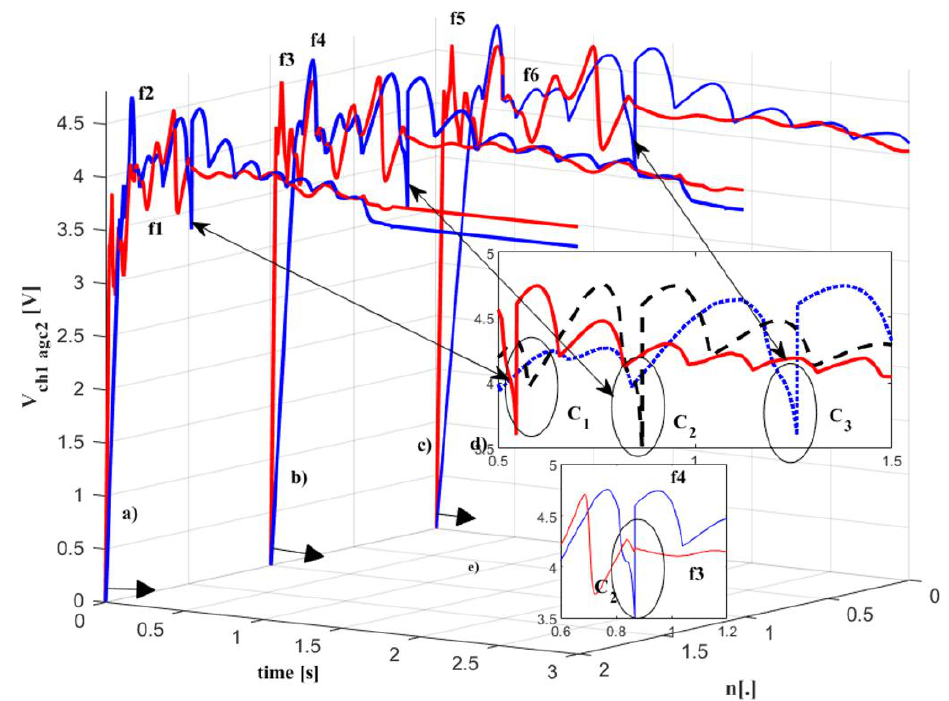
Figure 5. Waveforms of the output voltage fuzzy AGC (see terminal ch1_agc2 in Figure 3b) on the first-order polynomials function with slopes ( a ) 10°; ( b ) 45°; ( c ) 89° ( n []—iteration).